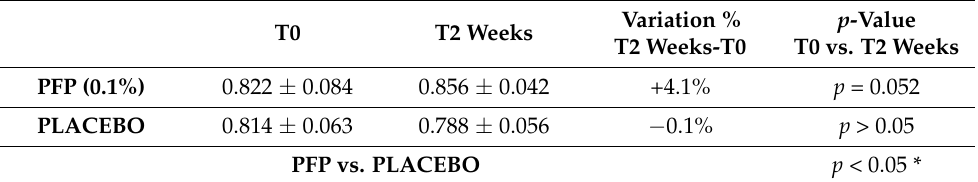
Table 2. Score values obtained by elasticity examination of active PFP-treated or placebo groups. Averages, standard deviations, variations and statistical significance ( p -value) for each group and between groups are reported. * p < 0.05.